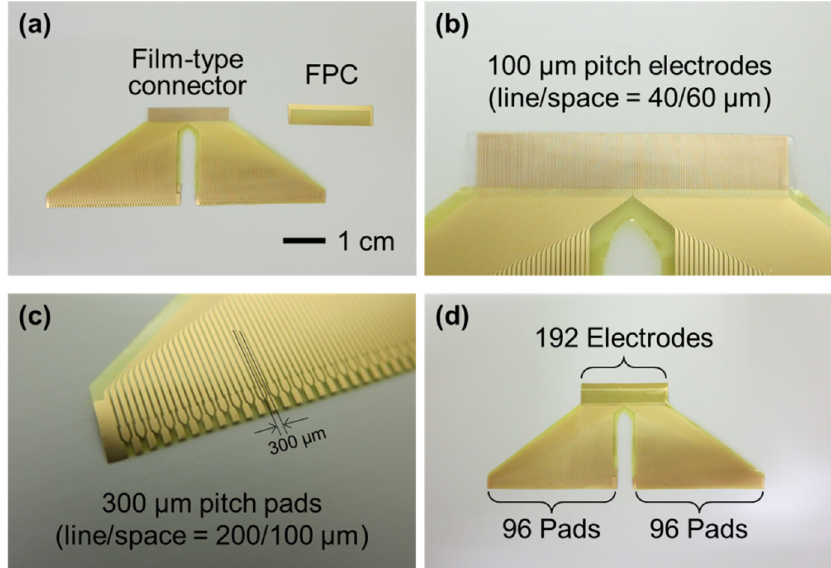
Figure 3. Photographs of the film-type connection: ( a ) the film-type connector and the FPC; ( b ) electrodes; ( c ) pads; and ( d ) connected